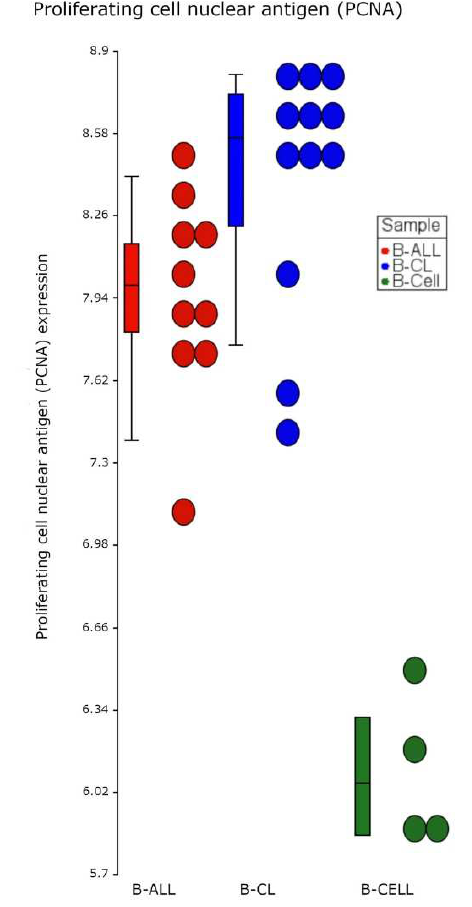
Figure 1. Dot plot expression of proliferating cell nuclear antigen (PCNA) in B-cell acute lymphoblastic leukemia and cell lines. The plot shows the level of PCNA gene expression in B-ALL cells from patients (red circles), B-ALL cell lines (B-CL, blue circles), and healthy B cells (B cells, green circles). We observed significant overexpression of PCNA in B-ALL and B-CL cells (FDR value = 4.23–54 and fold change 3.64) using